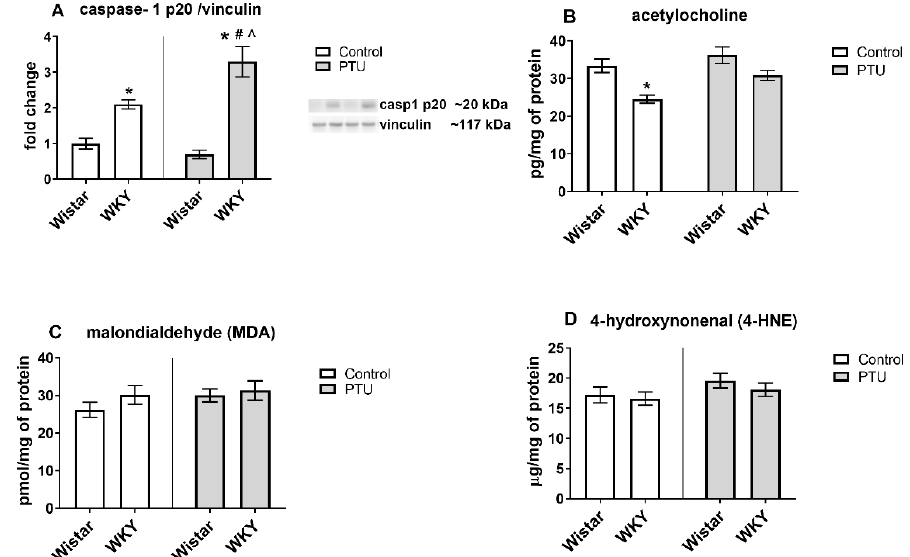
Figure 8. The effects of strain and PTU treatment on the protein levels of caspase-1 p20 ( A ), acetylcholine ( B ), malondialdehyde (MDA) ( C ), and 4-hydroxynonenal (4-HNE) ( D ). The results are expressed as the average fold change ± SEM ( A ) or the mean ± SEM ( B – D ). * p < 0.05 vs. the control group (Wistar rats); # p < 0.05 vs. the WKY group, ^ vs. the Wistar PTU group. n = 8–10.